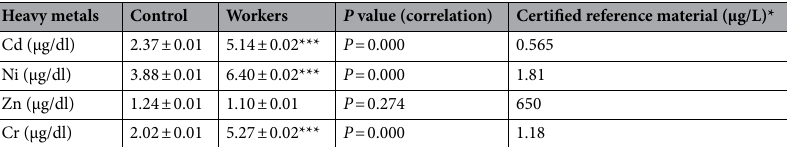
Table 3. Mean ± SEM heavy metals (lead, cadmium, nickel and chromium) concentration in whole blood of control and brick kiln male workers as well as from Seronorm certified reference material. Seronorm ® whole blood trace element level 2 (Ref. 210205) reference material by Sero AS (Billingstade, Norway) 46 . Values are